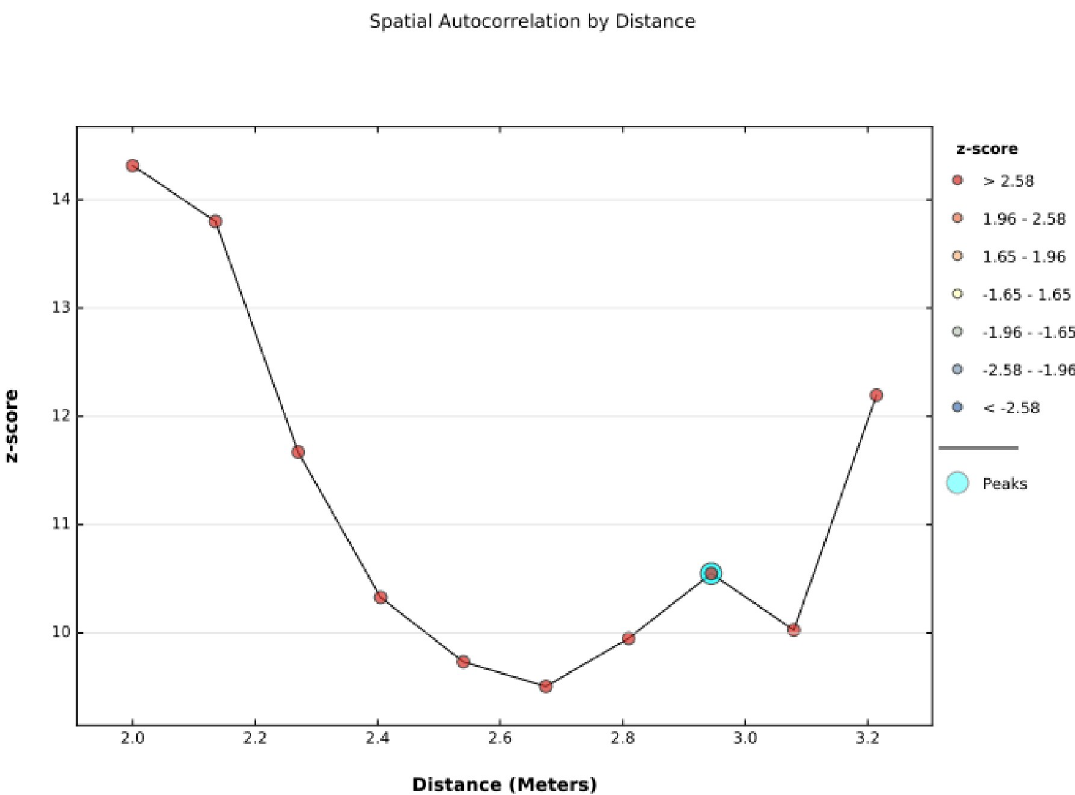
Fig 1. Incremental spatial autocorrelationof women unemployment status in Ethiopia, 2016